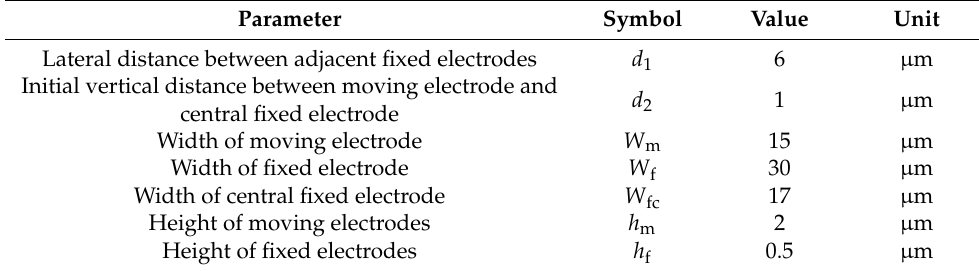
Table 1. Structural parameters of the electrostatic repulsive